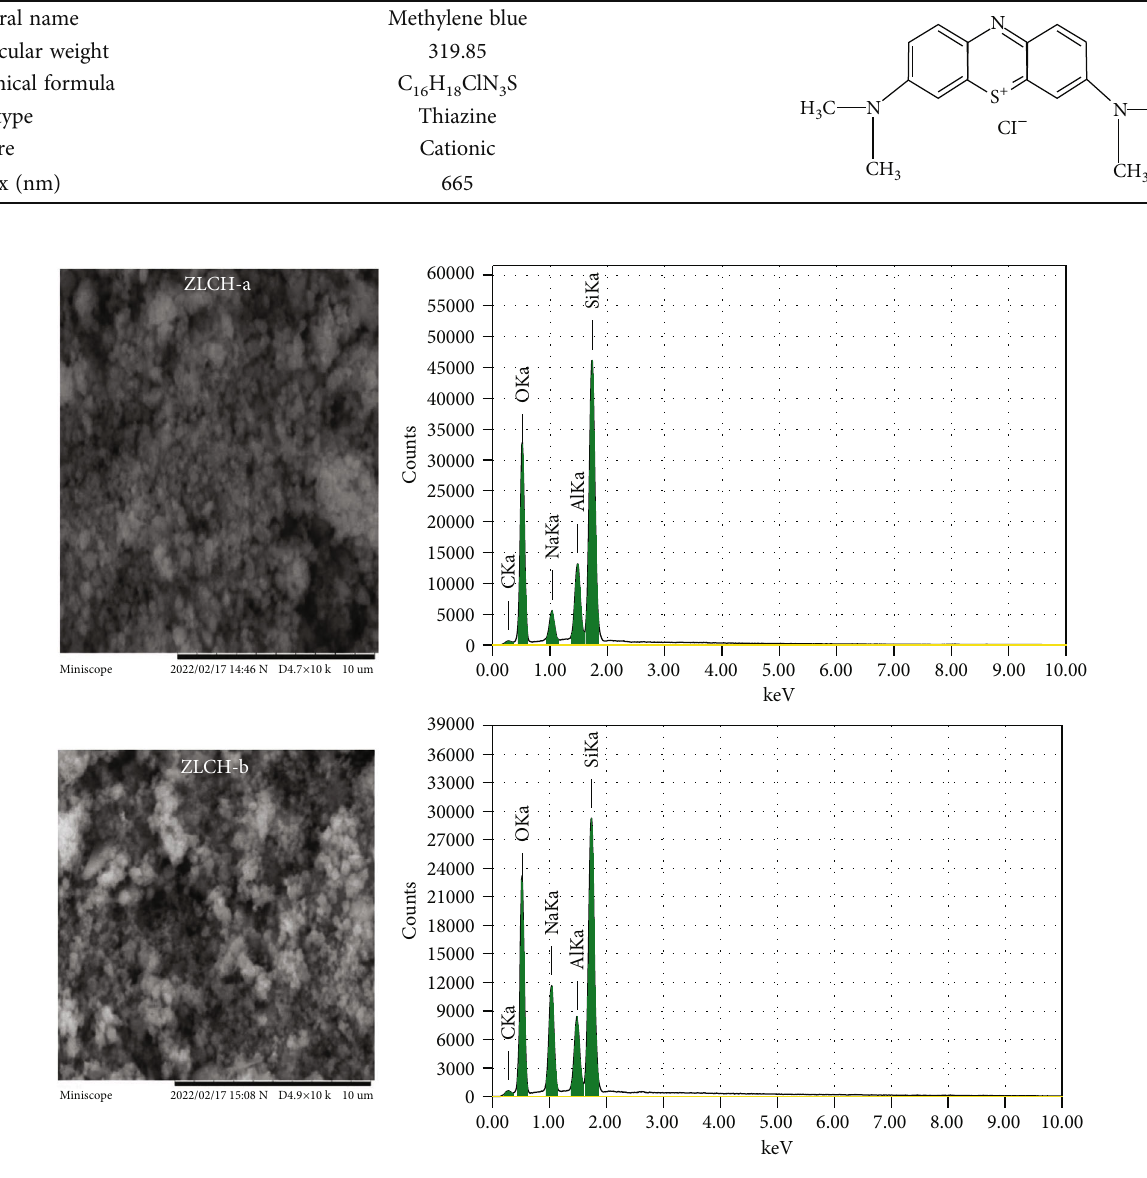
Figure 1: SEM images and EDS spectra of ZLCH-a and ZLCH-b. Table 2: Element data and speci fi c surface area of ZLCH-a and